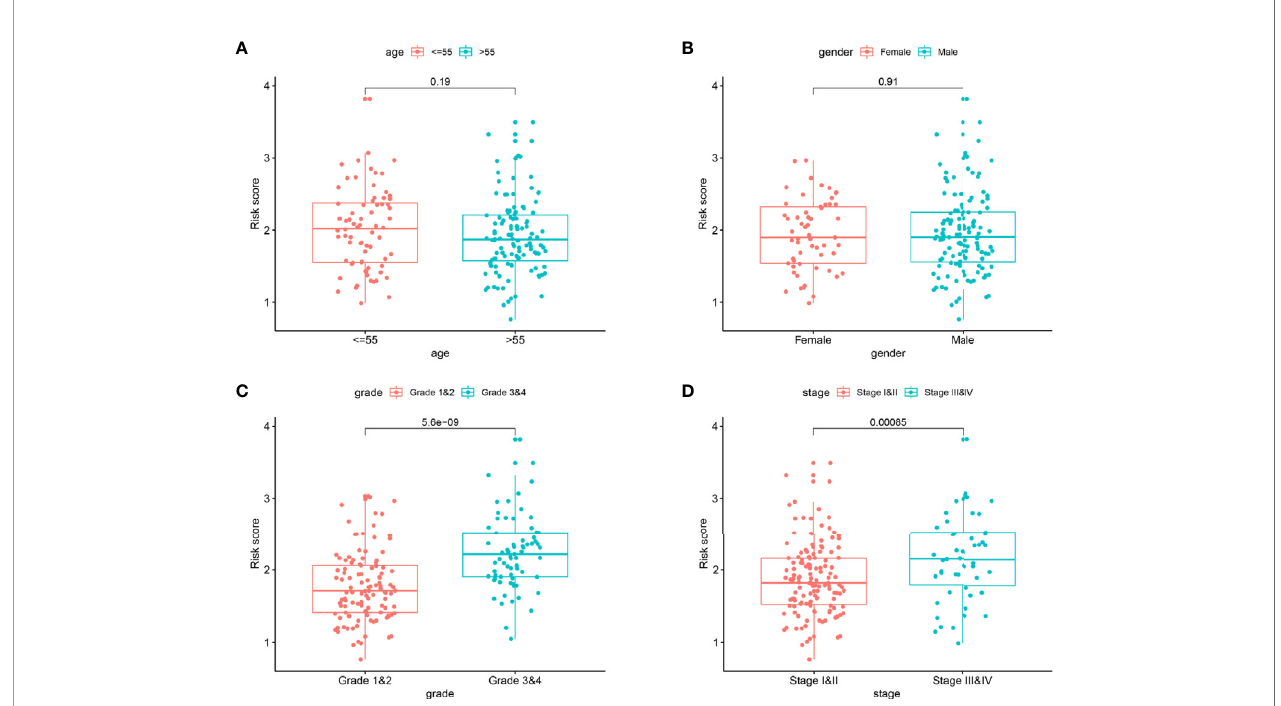
FIGURE 8 | The clinicopathological signi fi cance of the prognostic model. Age (A) and gender (B) were not associated with the risk score. Advanced pathological grade (C) and late clinical stage (D) were found to be associated with a high risk